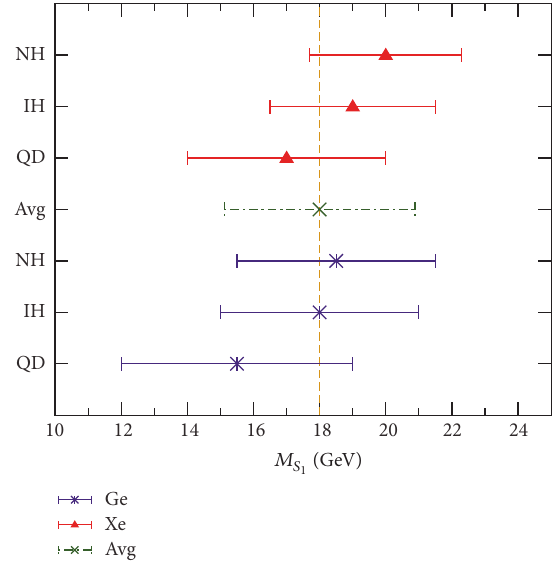
Figure 8: Prediction of light sterile neutrino mass from the satu- ration of experimental decay rates of ongoing searches for different active neutrino mass hierarchies. The horizontal green line indicates the average value of all